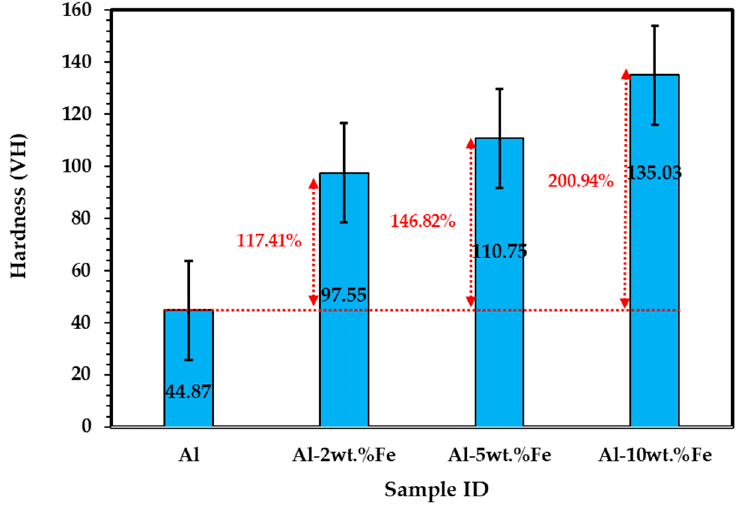
Figure 5. Hardness of Al and Al-Fe fabricated alloys.